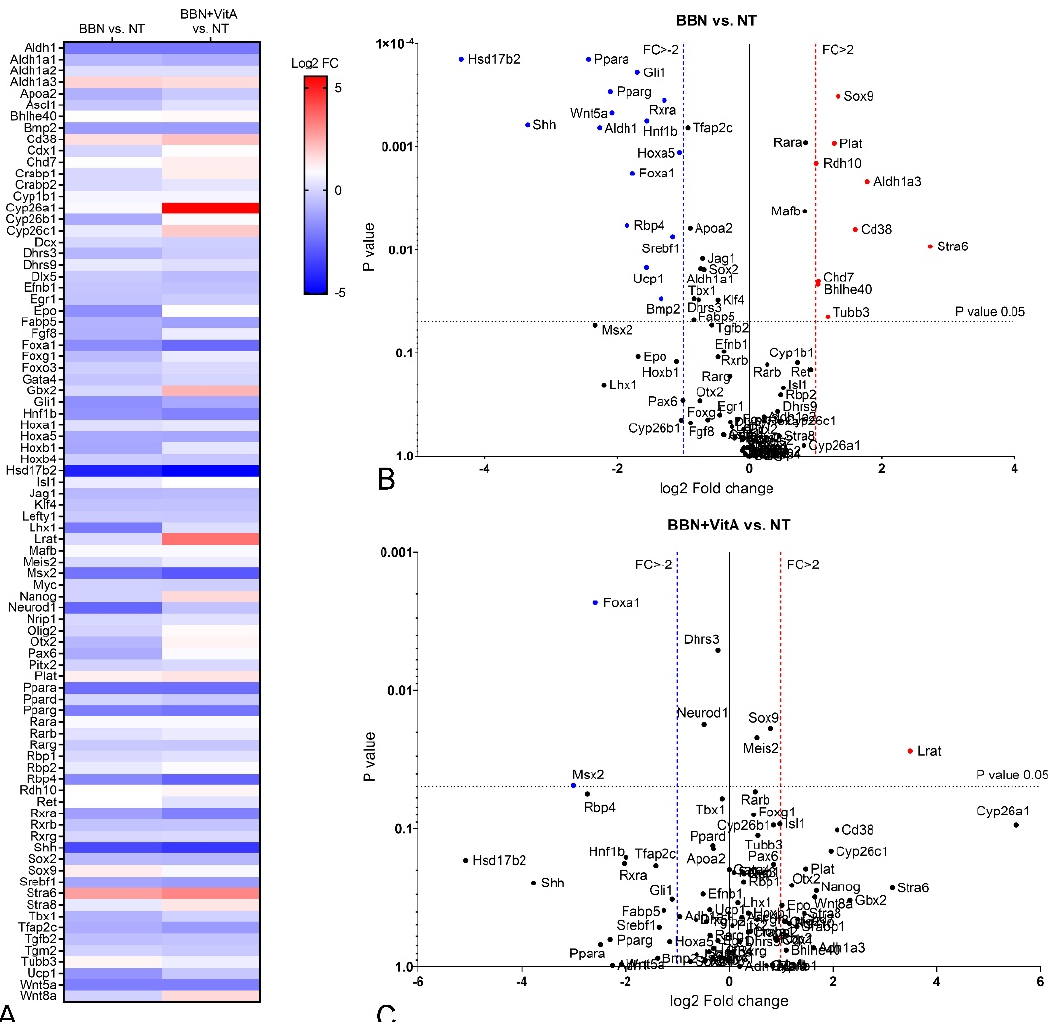
Figure 5. Differential expression of genes involved in retinoic acid signaling in mouse bladder tissue following BBN treatment and vitamin A rich diet. Comparisons of NT ( n = 9), BBN ( n = 9), and BBN + VitA ( n = 9) groups of animals. ( A ) Heatmap representation of fold change in gene expression in BBN vs. NT and BBN + VitA vs. NT. ( B , C ) Volcano plots showing comparison of BBN vs. NT and BBN + VitA vs. NT. For each group, three cDNAs, each containing RNA from three different mice, were used. Significantly affected gene expression with fold change greater then 2, upregulated or downregulated, is marked in red or blue, respectively ( p value < 0.05; tested by two-sided Student’s t -test). FC, fold change.